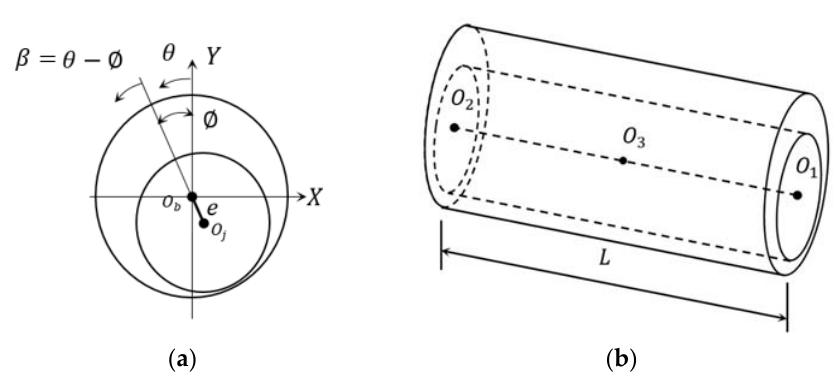
( c ) Figure 2. Schematic drawing illustrates: ( a ) side view of aligned bearing, ( b ) 3D aligned bearing, and ( c ) misalignment model [30]. The attitude angle and the eccentricity in the case of the misaligned bearing are func ‐ tions of z position, which can be given by [30] ∅(cid:4666)𝑧(cid:4667) (cid:3404) 𝑡𝑎𝑛 (cid:2879)(cid:2869) (cid:3032) (cid:3046)(cid:3036)(cid:3041) ∅(cid:2878)(cid:3083)(cid:3035)(cid:4666)(cid:3053)(cid:4667) (cid:3032) (cid:3030)(cid:3042)(cid:3046) ∅(cid:2879)(cid:3083)(cid:3049)(cid:4666)(cid:3053)(cid:4667) for 𝑧 (cid:3409) 𝐿/2 𝑒(cid:4666)𝑧(cid:4667) (cid:3404) (cid:3493)(cid:4666)𝑒 cos ∅ (cid:3398) 𝛿𝑣(cid:4666)𝑧(cid:4667)(cid:4667) (cid:2870) (cid:3397) (cid:4666)𝑒 sin ∅ (cid:3397)𝛿ℎ(cid:4666)𝑧(cid:4667)(cid:4667) (cid:2870)